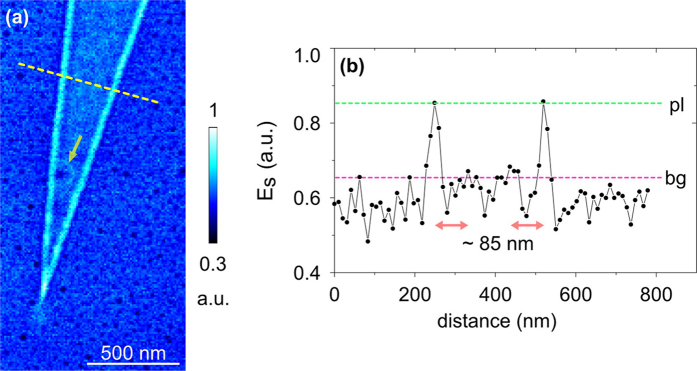
Near-field imaging of the graphene on NS-SiO2, performed at λ1 = 10 μm(a) Near-field optical image. The yellow arrow marks an optical ring structure around a single “extra-high” NS dot beneath graphene. (b) Corresponding cross-section along the dotted yellow line in image (a) Green and pink dotted lines mark GP field magnitudes at the first maximum close to graphene edges, and inside the inner part of the graphene flake. Red arrows highlight a distance between first and second maxima of GP field distribution.